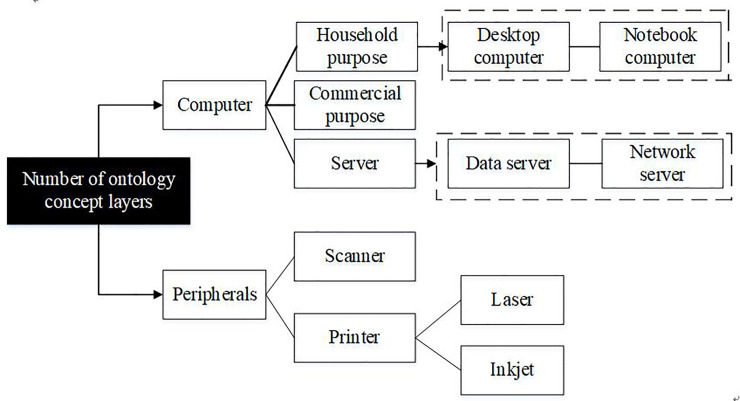
Construction process of ontology concept tree.